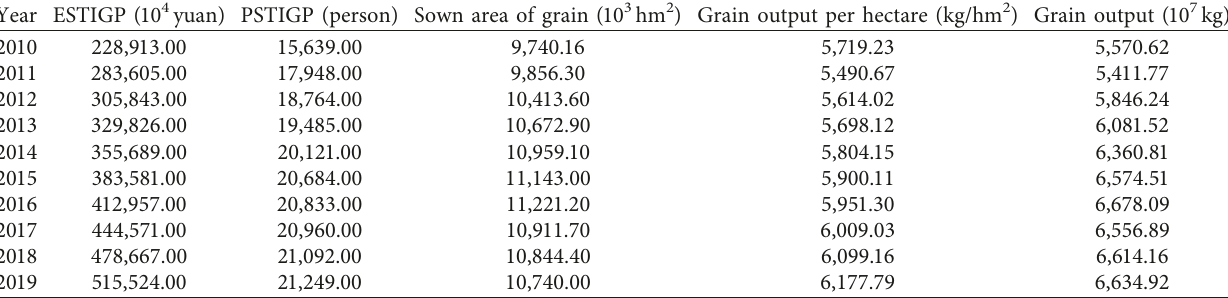
Table 2: Simulation value of grain production scientific and technological innovation